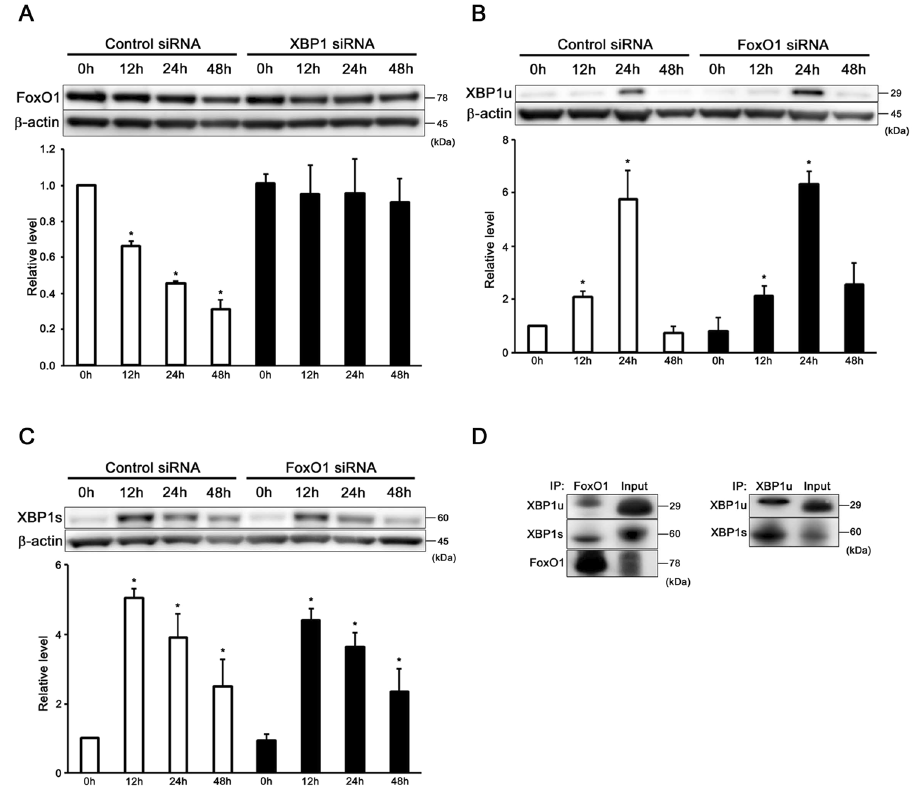
Figure 7. XBP1 regulates the FoxO1 expression in auditory cells under ER stress condition. ( A ) XBP1 KD cells showed no significant change in the FoxO1 expression. β -actin was included as a loading control. The expressions of FoxO1 was detected, and the mean ± S.D. (fold of changes over the control group) of three or more independent studies were presented ( * p < 0.05 versus control group). Full-length blots are presented in Supplementary Figure 7a and b. ( B , C ) FoxO1 KD cells showed no significant difference of the XBP1u and XBP1s expressions in comparison with si-control cells. β -actin was included as a loading control. The expressions of XBP1u and XBP1s were detected, and the means ± S.D. (fold of changes over the control group) of three or more independent studies were presented ( * p < 0.05 versus control group). Full-length blots are presented in Supplementary Figure 7c–f. ( D ) Co-immunoprecipitation revealed physical interactions between XBP1u, s and FoxO1 in auditory cells. Data presented are representative of three independent